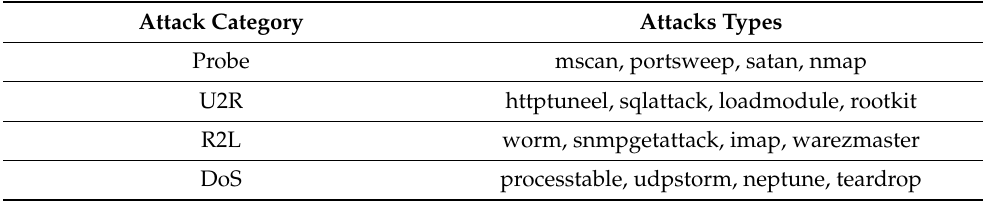
Table 8. List of attacks categories in IoT